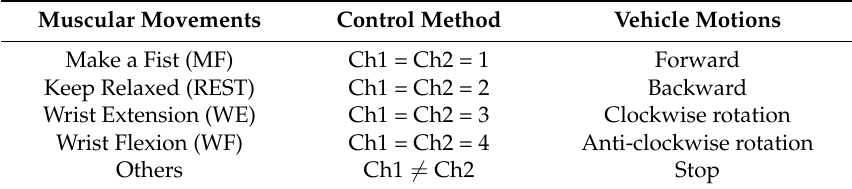
Table 3. Definition of muscular movements and control method in Paradigm 3 and 4.